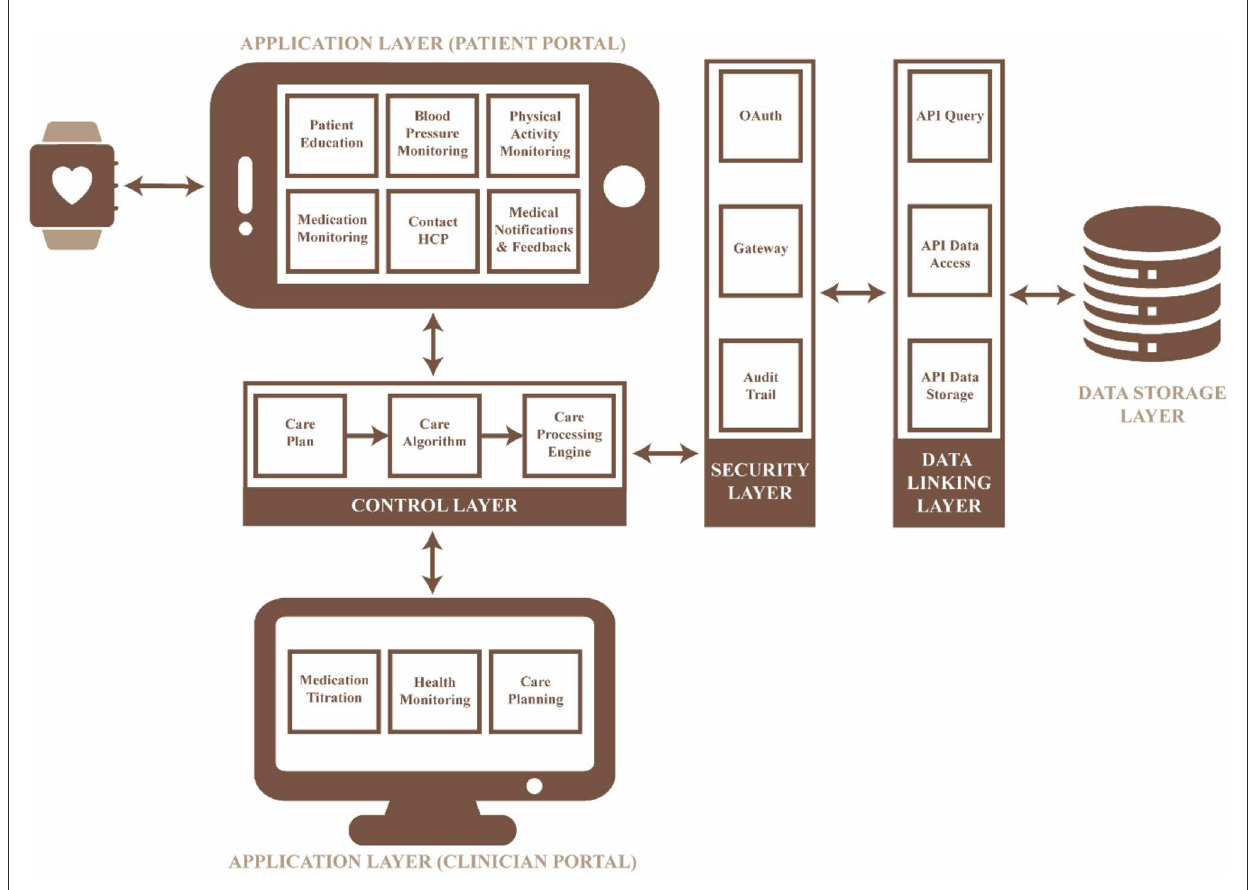
FIGURE4 High-level technical model for the hypertension self-management mHealth